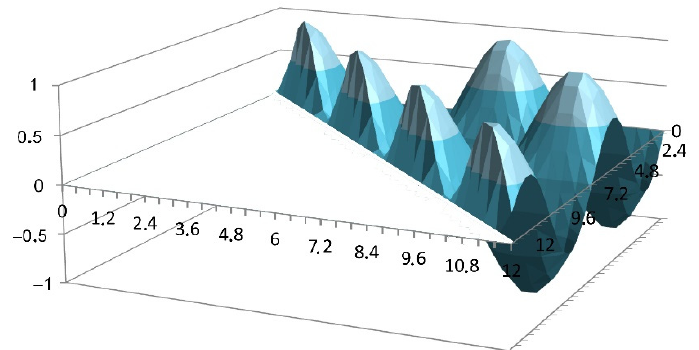
Figure 10. The surface generated by the function f ( τ (cid:48) , τ (cid:48)(cid:48) ) = sin( τ (cid:48) )sin( τ (cid:48)(cid:48) ). The integral I num =